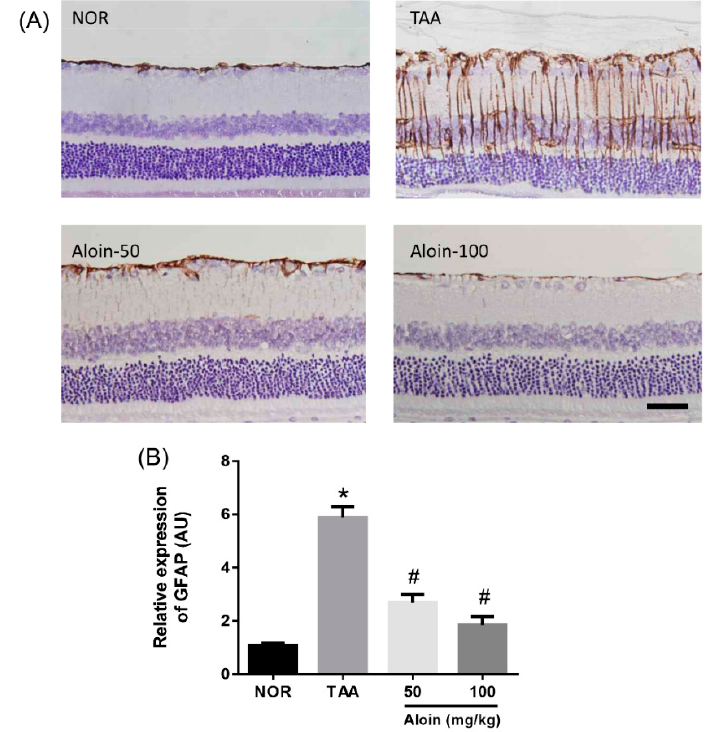
Figure 5. Effect of aloin on glial fibrillary acidic protein (GFAP) expression. ( A ) Immunohistochemical staining for GFAP in the retinal tissues sections. Scale bar = 50 µm. ( B ) Quantitative analysis of signal intensity. Values in the bar graphs represent the mean ± SEM, n = 7. * p < 0.05 vs. normal control rats, # p < 0.05 vs. TAA-injected rats.